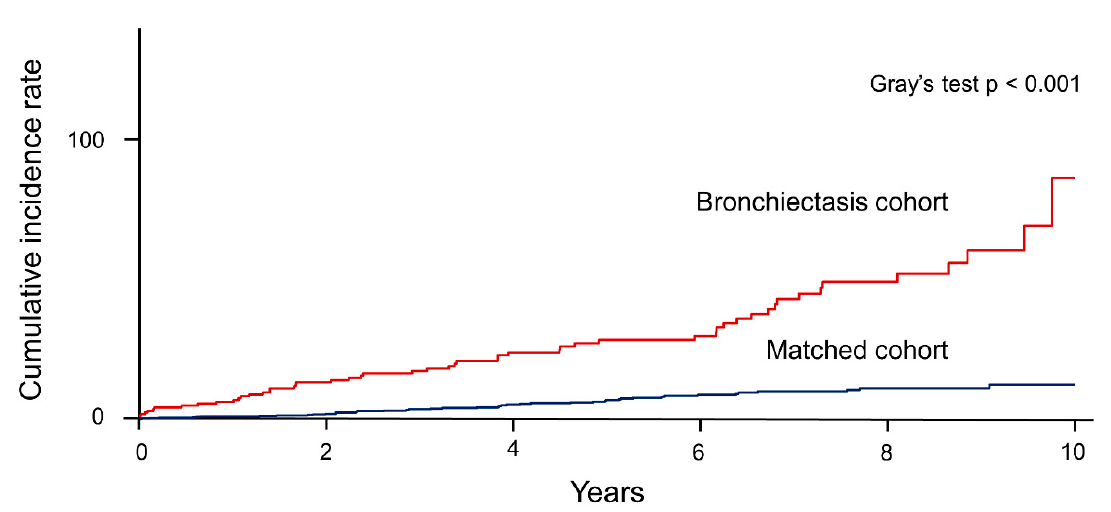
Figure 2. Cumulative incidence of aspergillosis (/100,000 person-years) in the bronchiectasis and matched cohorts.